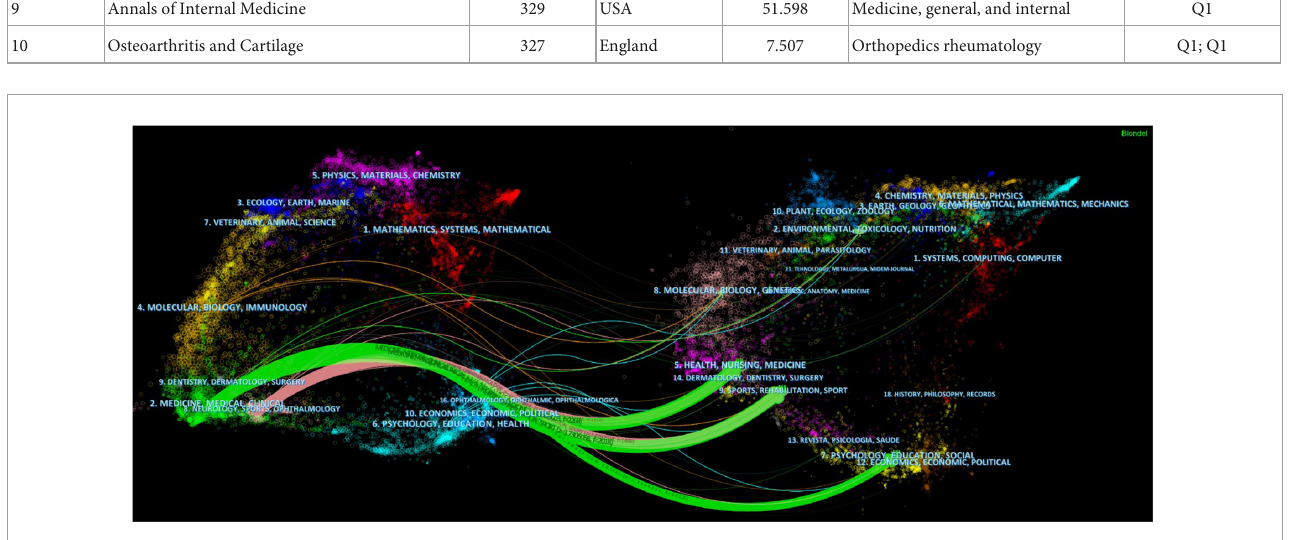
FIGURE3 The dual-map overlay of journals.